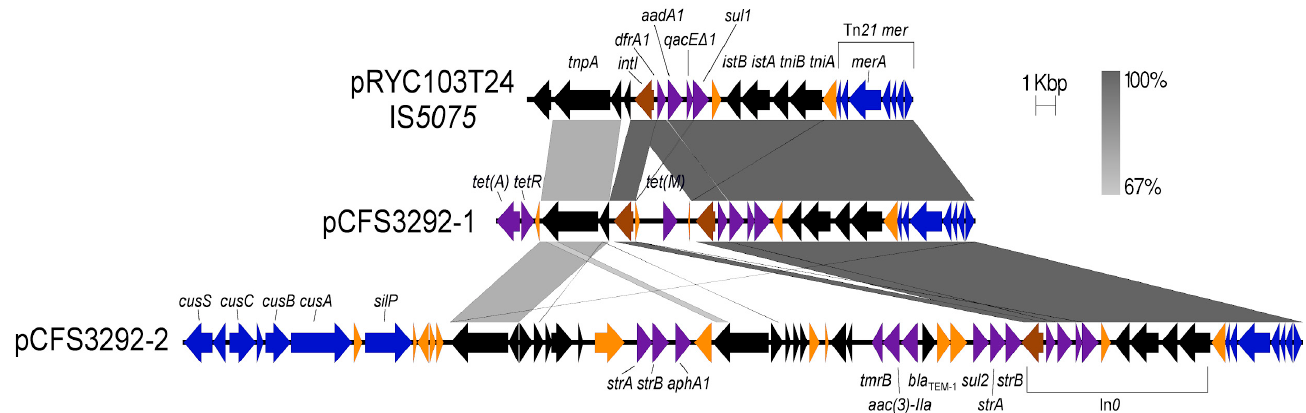
Figure 4. Complex AMR-encoding region in plasmids pCFS3292-1, pCFS3292-2, and IS 5075 from plasmid pRYC103T24. Tetracycline resistance tet (B) and tetR are associated with the IS 5075 in plasmid pCFS3292-1 as well as the uncommon tet (M) resistance gene. Plasmid pCFS3292-2 contains an additional complex AMR module with bla TEM-1 and two identical copies of strAB . Colour scheme: antimicrobial resistance genes (purple), heavy metal resistance genes (blue), transposons and insertion elements (black), and integrases (brown). Other genes are represented in orange.